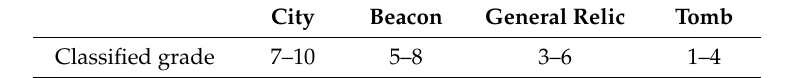
Table 4. Classification of relative importance in the defensive system. The importance is ranked in four